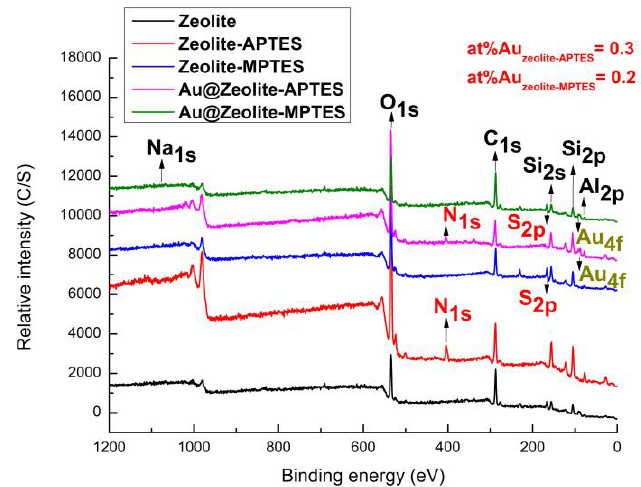
Figure 3. XPS survey scan spectra of zeolite, APTES/MPTES deposited zeolite and AuNPs immobilized zeolite.